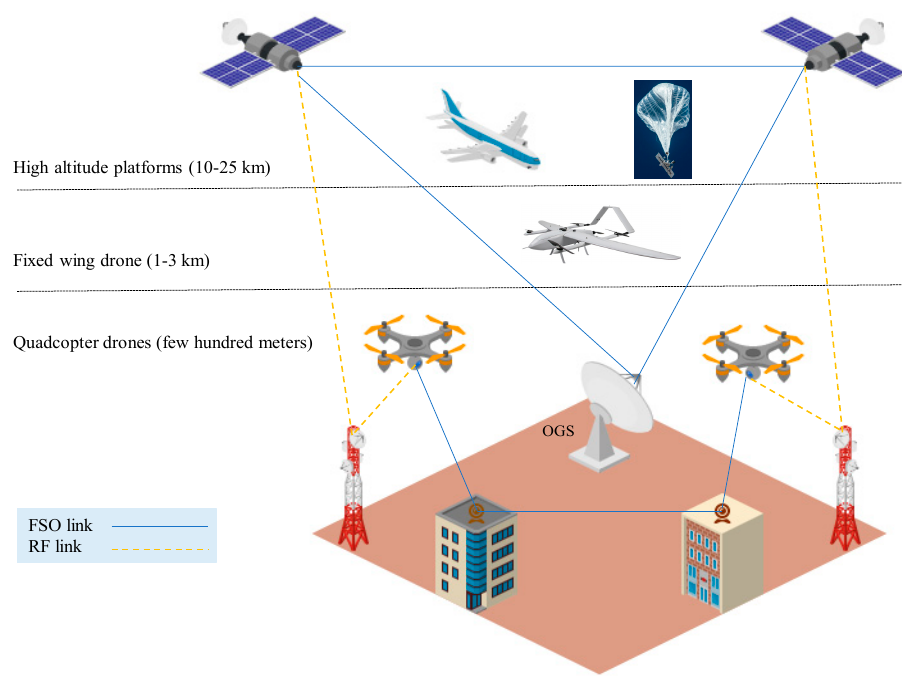
Figure 1. Different areas where FSO link can be applied for 5G and Beyond Network.